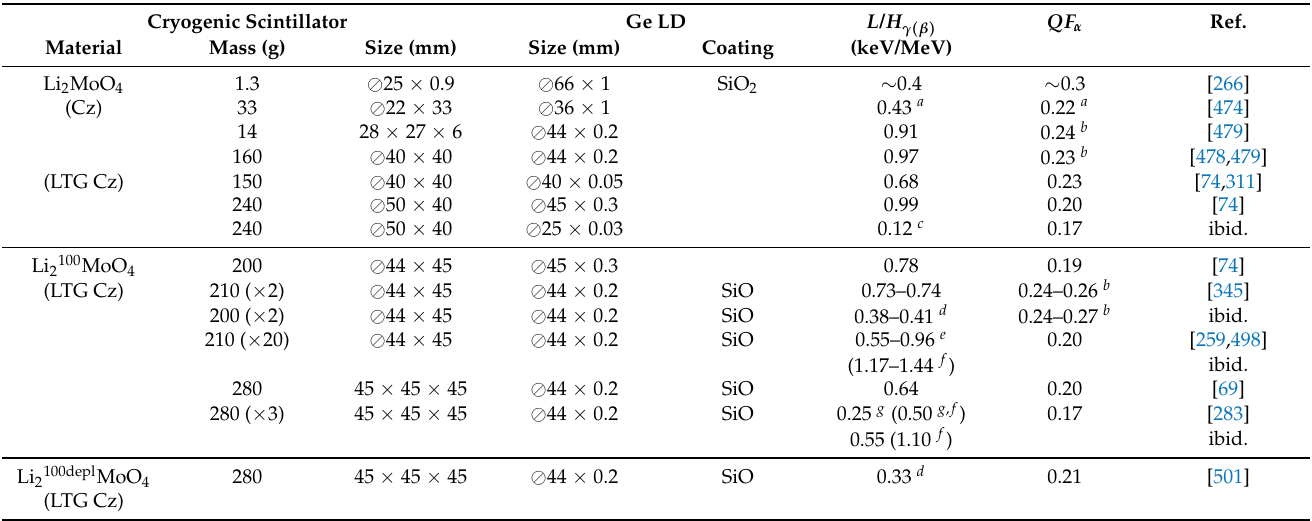
a The L / H ∼ 0.7 keV/MeV, in contradiction to Figures 2–4 (ibid.); this discrepancy is γ ( β ) evaluated from the data shown in Figure 7 [474] is probably the origin of the reported QF α = 0.43 [474]. b Estimated for α +t events (4.8 MeV sum energy), products of neutron capture by 6 Li. c Affected by smaller area of an LD compared to one of the faced crystal side. d No reflective foil, but a Cu housing. e Such spread is mainly due to the light collection difference imposed by the detector design (see text). f Combination of two identical LDs. g No reflective cavity, that is fully open detector